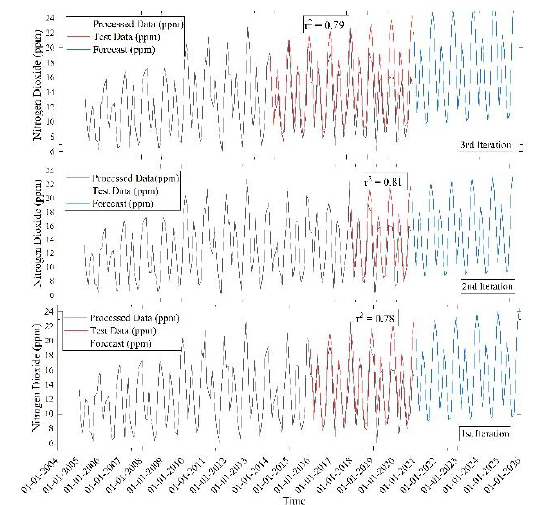
Figure 8: Forecast of Nitrogen dioxide from year 2021 to 2025 using three iterations according to different training periods. First iteration uses 10 years data for training and 5 years as test. Second iteration uses 12 years data for training and 3 years as test. Third iteration uses 8 years data as training and 7 years as test.